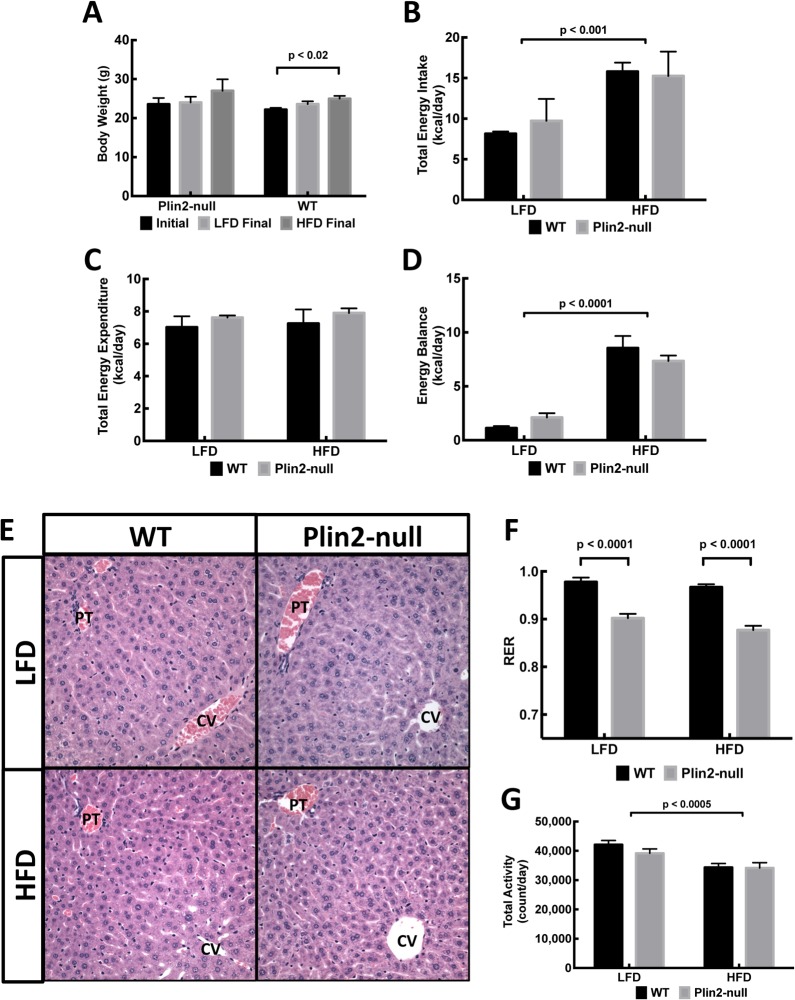
Metabolic effects of four-day LF and HF feeding on WT and Plin2-null mice.(A) Body weights of eight-week-old WT and Plin2-null fed the chow diet for 5 weeks (Initial) and after four days of LF (LFD Final) or HF (HFD Final) diet feeding. (B-D) Energy intake (B), energy expenditures (C) and energy balance (D) properties. (E) Representative H&E stained liver sections of LF and HF fed WT or Plin2-null mice at 200X magnification. PT, portal triad. CV, central vein. (F,G) Average respiratory exchange ratios (RER) (F), and total activities (G) of WT and Pln2-null mice fed LF or HF diets. Data were analyzed by 2-way ANOVA examining the effects of diet, genotype, and their interaction. Statistical significance of diet on each parameter is indicated in the respective figures. All values are means ± SEM, N = 4 per group.